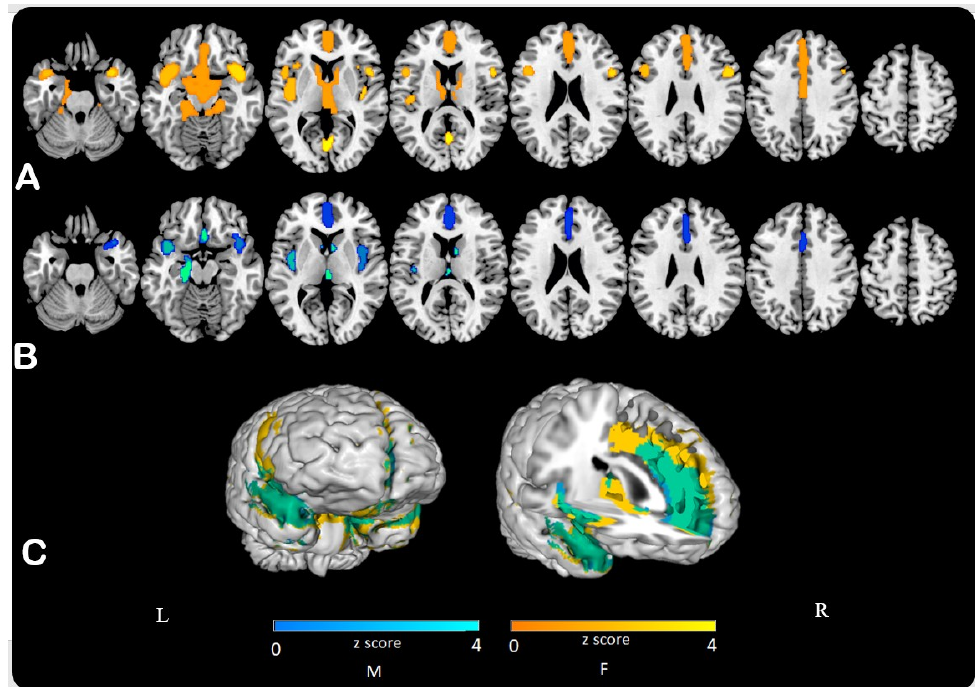
Figure 3. Using P as reference, statistical parametric maps (SPMs) showed a wider negative correlation between age and 18F-FDG uptake value in female ( A ) than in male group ( B ). SPMs are represented on a color-coded scale (0 < z < 4) and displayed on a standardized brain magnetic resonance imaging. In the surface representation ( C ) of SPMs, green represents common areas between females (F) and males (M) analyses.